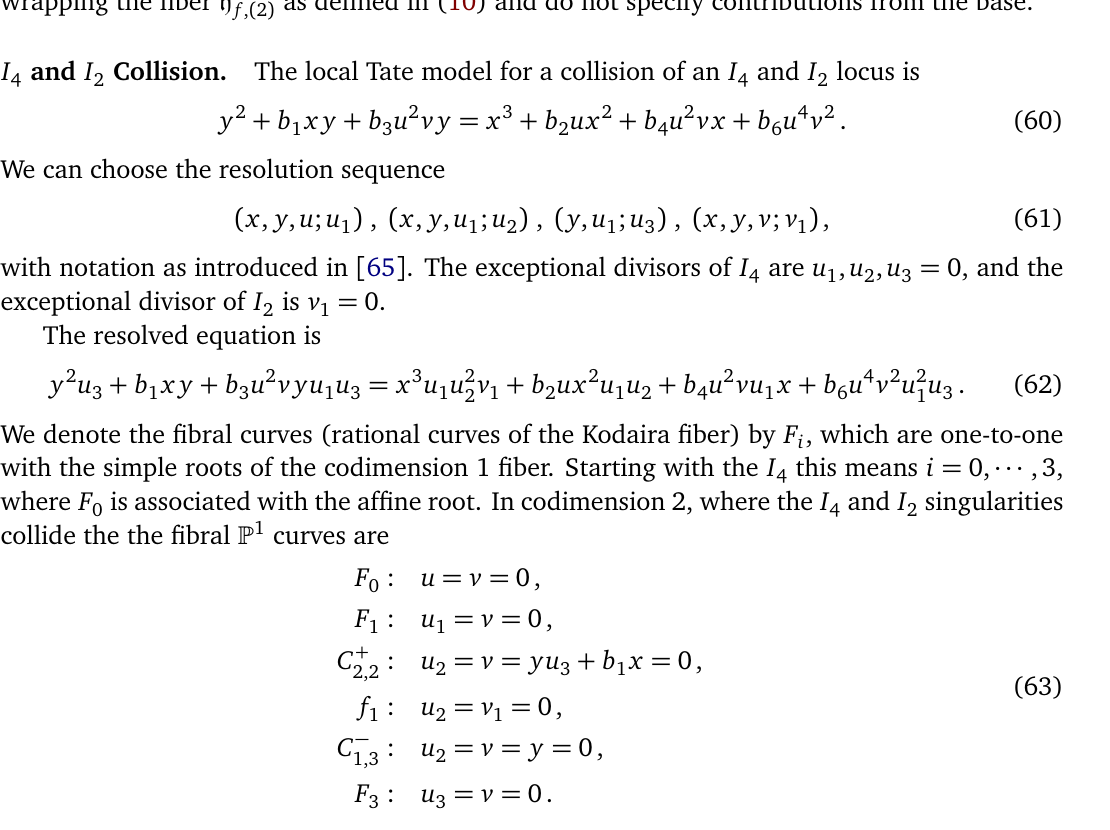
Figure 8: The fiber (black) projecting to the intersection point of an I The pairs ( − n , − m ) are self intersections within u = 0 and v = 0 respectively. The normal bundle of curves are either O ( − 2 ) ⊕ O ( 0 ) or O ( − 1 ) ⊕ O ( − 1 ) . We have also depicted the intersection points of Kodaira thimbles of the I (blue) with the codimension 2